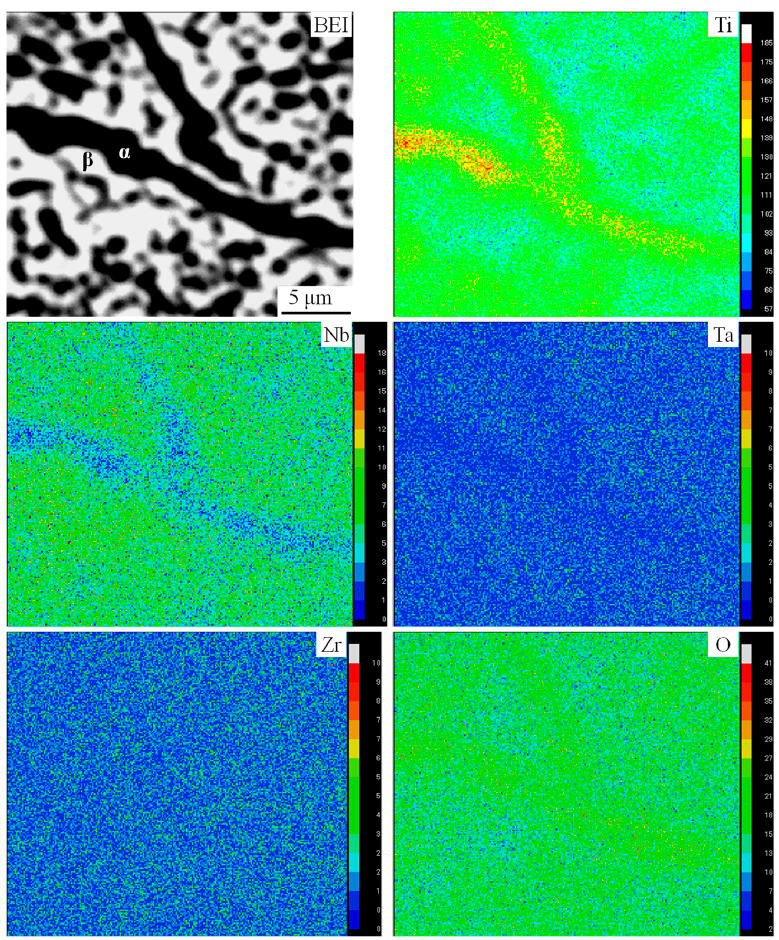
Figure 3. Distribution of elements in 2Zr-10O alloy. XRD profiles of 2Zr-4O, 2Zr-6O and 2Zr-10O alloys are presented in Figure 4. It confirmed that the alloys contained α and β phases.